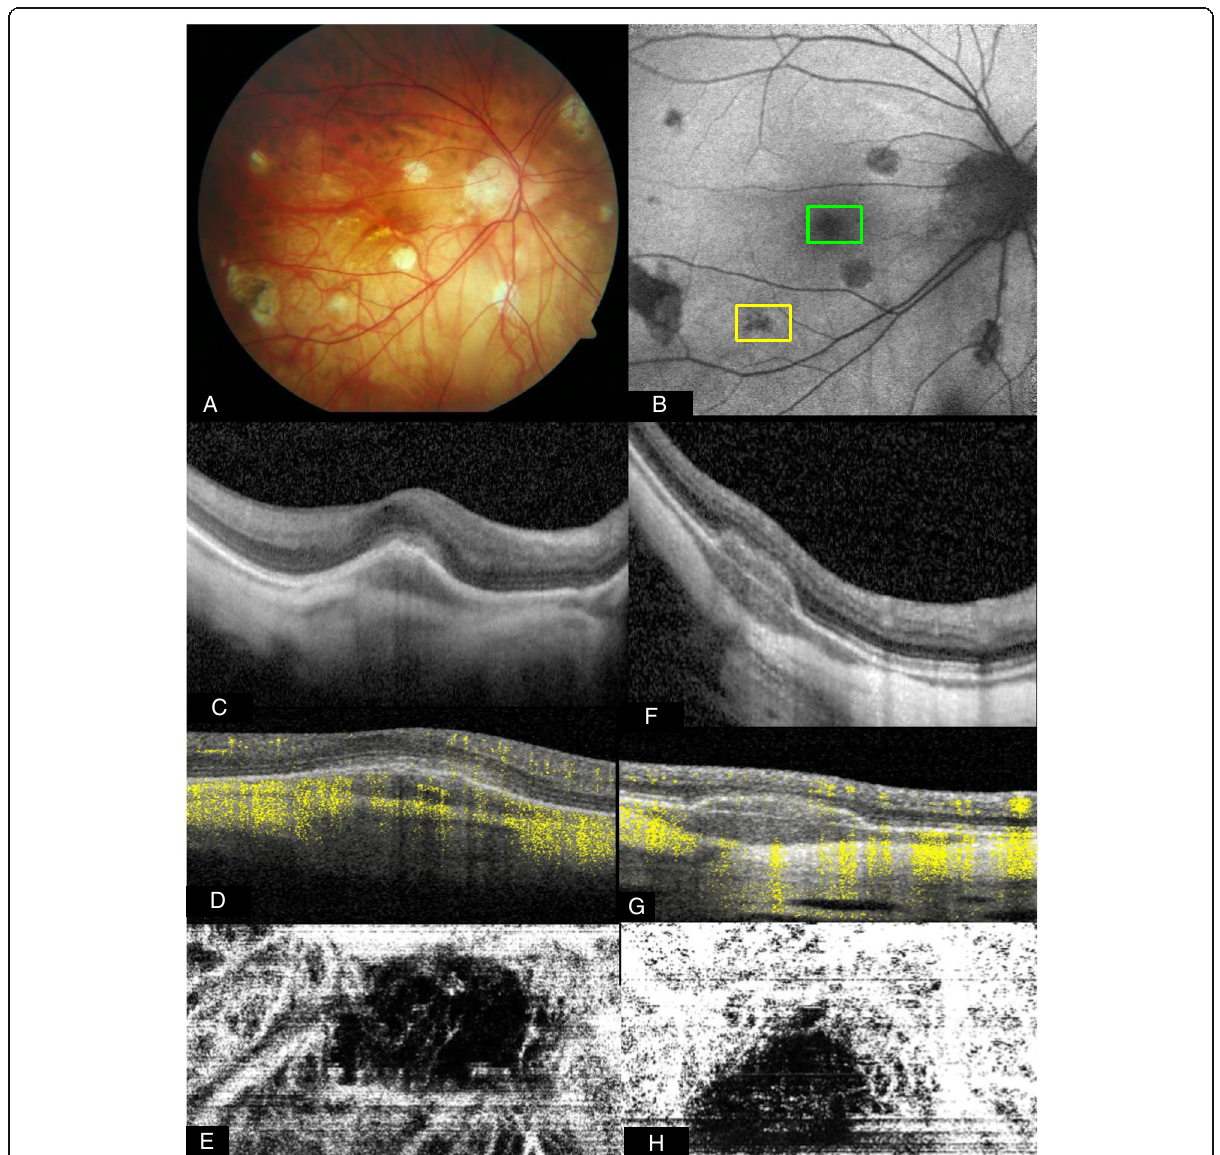
Fig. 4 Optical coherence tomography angiography (OCTA) for differentiating acute inflammatory lesions from choroidal neovascularization in a myopic eye with idiopathic multifocal choroiditis. a Color photograph shows multiple yellowish-gray lesions perifoveolar and nasal the optic nerve head. b Fundus autofluorescence in this case shows unspecific mottled hypoautofluorescence of the lesions. c Structural OCT scan over the lesion within the green box in panel B shows hyperreflective material below and minimal above the retinal pigment epithelium (RPE). d Cross-sectional OCTA of the same lesion demonstrates slightly abnormal flow above the RPE, representing type 2 neovascularization. e En face OCTA reconstruction, which shows a small choroidal neovascularization. f Structural OCT scan over the lesion within the yellow box in panel b shows hyperreflective material below the RPE and a well-defined Bruch ’ s membrane. g Cross-sectional OCTA shows the absence of abnormal flow beneath the RPE. The flow overlying the RPE layer represents the projection of the flow signal from the more superficial retinal circulation (projection artifact). h En face OCTA reconstruction. It looks like vascular branches of a choroidal neovascularization, but scrolling the slap through the retina represents a projection